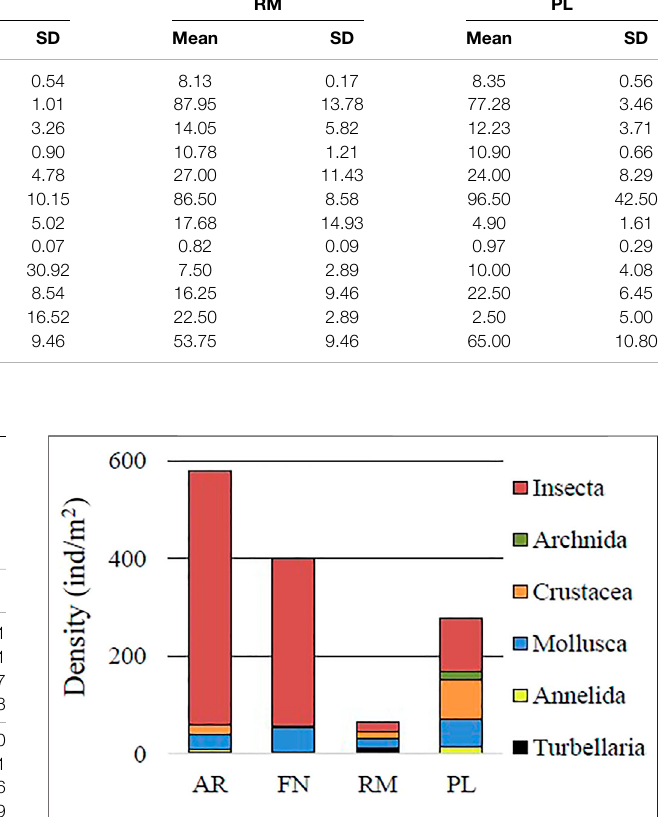
FIGURE 2 | Density of macroinvertebrate groups of sampling river (AR, Arroyito; FN, Fortín Nogueira) and reservoir (RM, Ezequiel Ramos Mexía; PL, Pichi Picún Leufú) sites of Limay River, Patagonia.